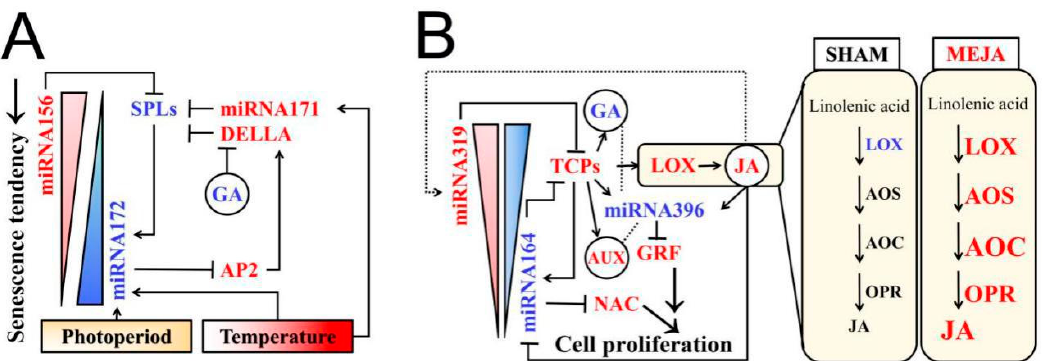
Figure 7. Interaction pattern between miRNA and phytohormone regulating pollen fertility in PTGMS and PGMS. ( A ) Work pattern of GA and miRNA156-miRNA172 in senescence mechanism. ( B ) Crosstalk pattern of JA, IAA, GA and miRNA164-miRNA319 in cell proliferation mechanism. Compared to those in sterile plants, miRNAs and their target genes downregulated/upregulated in fertile spikelets are marked in blue/red color according to our previous results of PA64S [46]. For spray treatment of PGMS, gene expressions of JA synthesis downregulated/upregulated in fertile NK58S and D52S spikelets are marked in blue/red color, according to data in Figures 5 and 6.